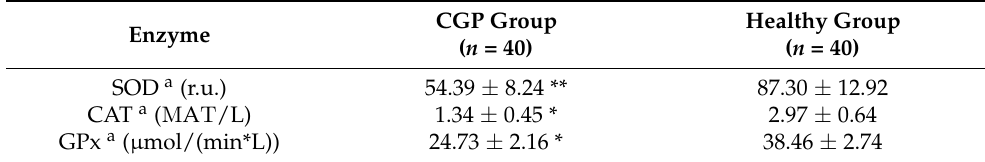
Table 4. Activity indices of the enzymatic component of the saliva antioxidant protection in patients with chronic generalized periodontitis. CGP: chronic generalized periodontitis. Enzyme